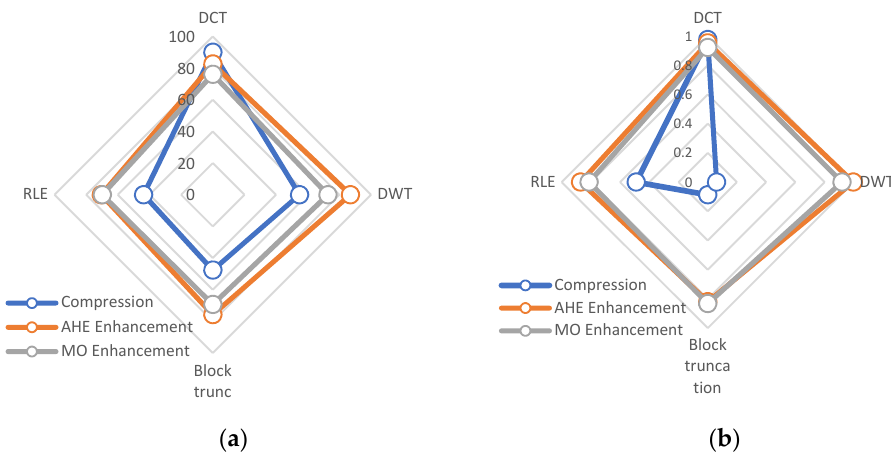
Figure 6. The performance of the presented methods ( a ): PSNR criteria, ( b ): SSIM criteria. Table 2. The comparison between the presented methods and the state ‐ of ‐ the ‐ art. Method MSE PSNR Presented DCT 4.15 × 10 − 5 89.98